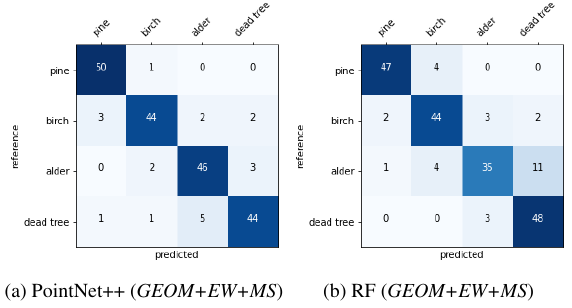
Figure 8. Confusion matrices on the test dataset using geometry information, EW values, and MS features.